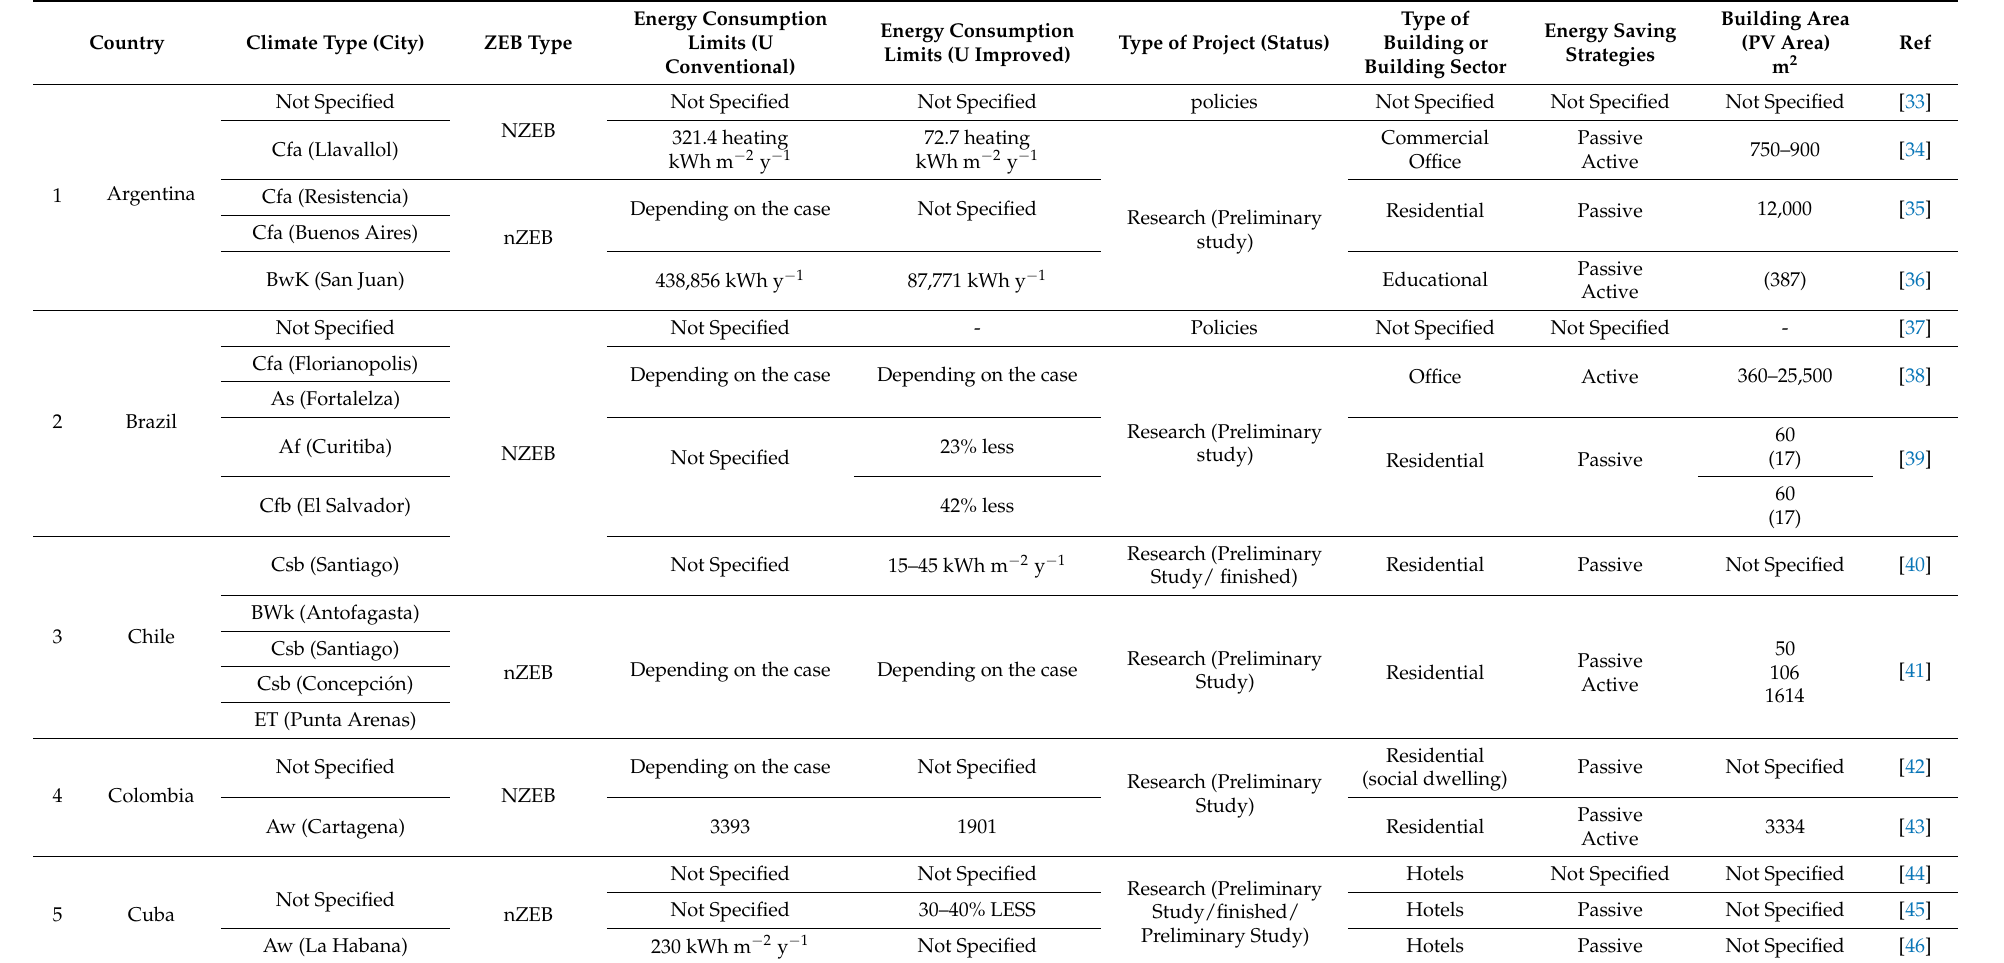
Table 1. Countries in Latin America with experience in nZEB or